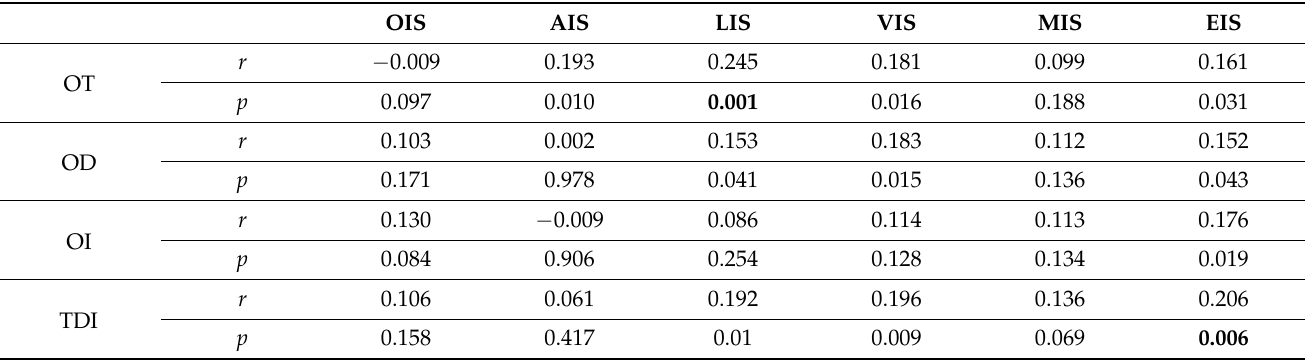
Table 3. Correlations between parameters of olfactory dysfunction (OT, OD, OI and TDI) and specific index sub-scores of MoCA in patients affected by Parkinson’s disease. Significance was set at the 0.0083 level after Bonferroni correction.